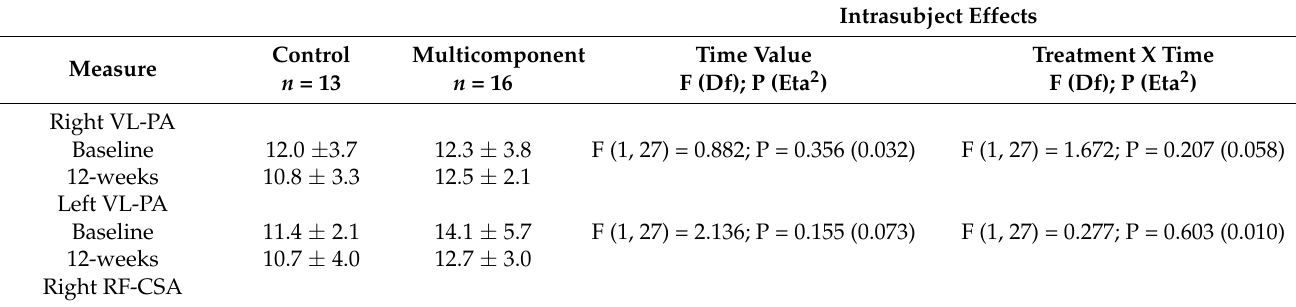
Table 2. Vastus lateralis pennation angle, rectus femoris thickness, cross-sectional area, echointensity, echovariance, muscle power and muscle strength intrasubject